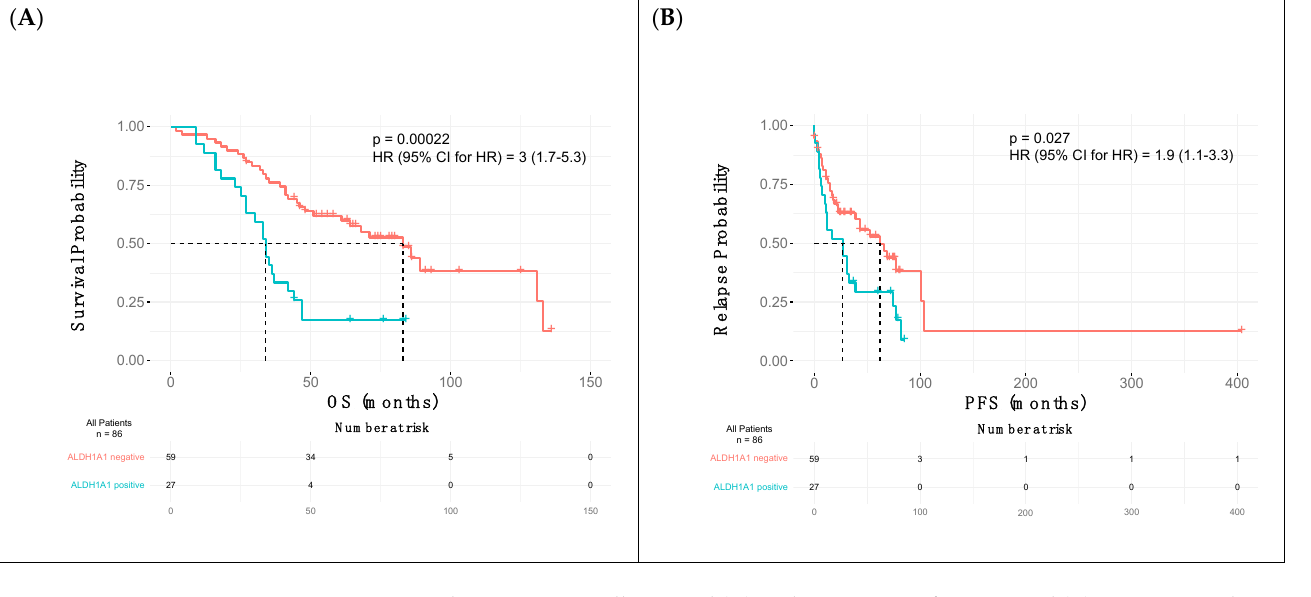
Figure 2. Kaplan–Meier overall survival ( A ) and progression-free survival ( B ) curves according to the ALDH1A1 expression.